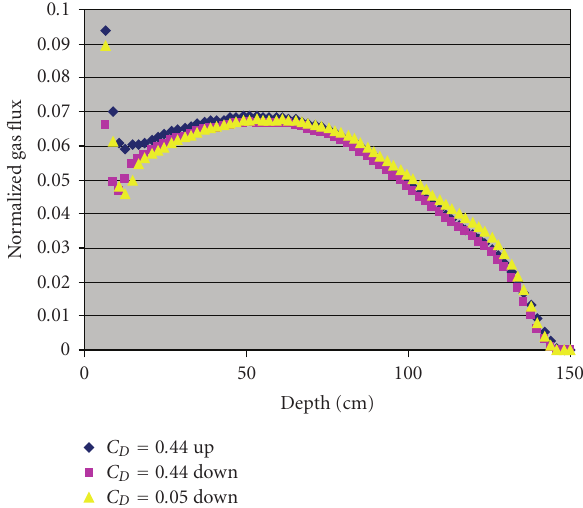
Figure 9: Normalized gas fluxes as function of the depth below the water level. Blue symbols: upward gas flux ( C D = 0 . 44). Red symbols: downward gas flux ( C D = 0 . 44). Yellow: downward gas flux ( C D = 0 .